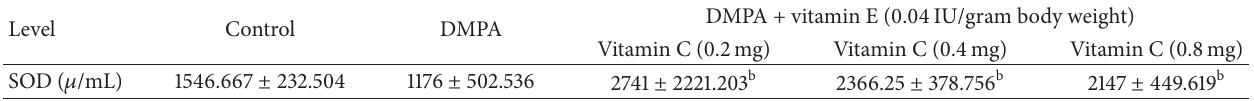
Table 3: Levels of ovarian superoxide dismutase in each experimental